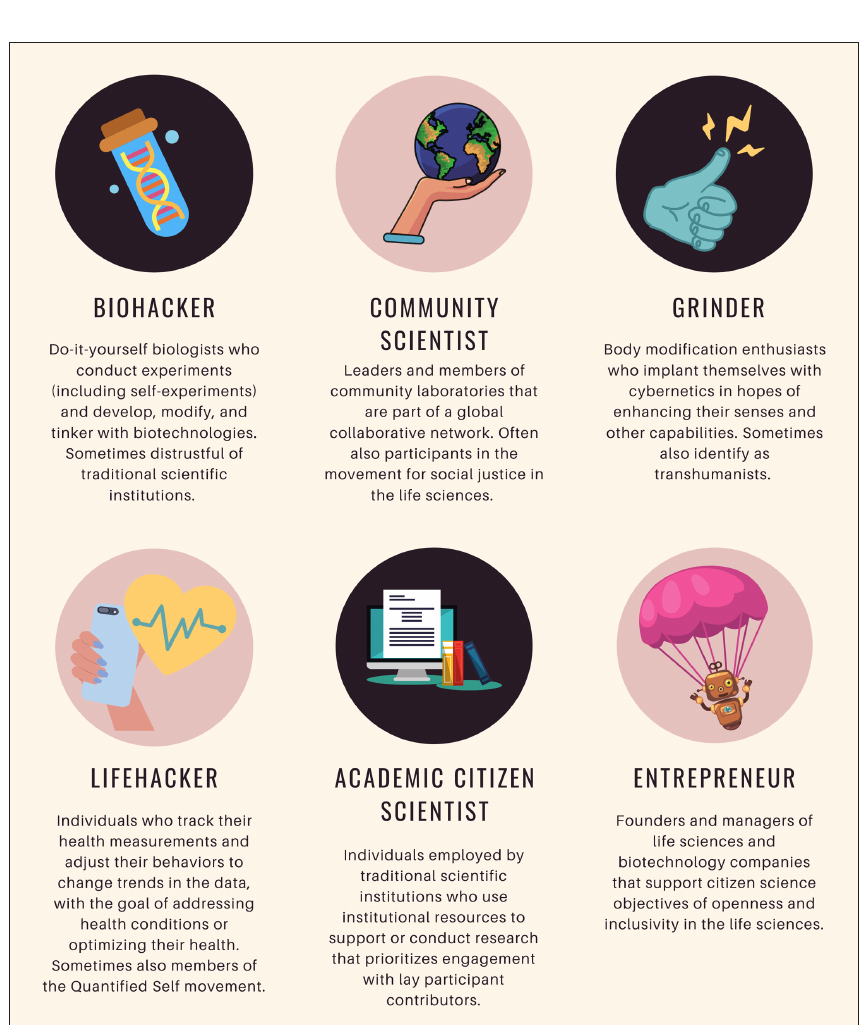
Figure 1 Major biomedical citizen science